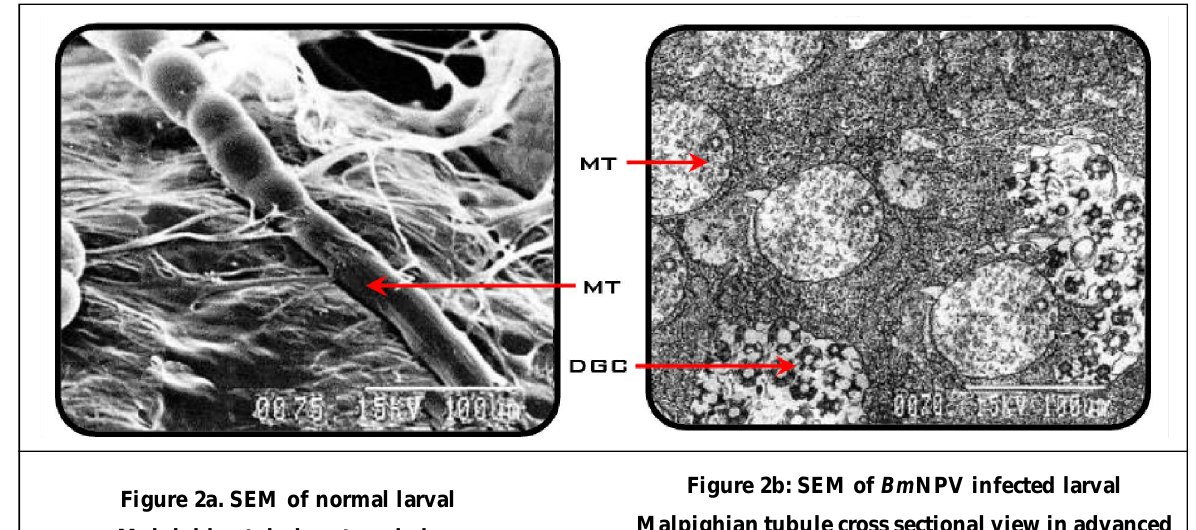
Figure 2a. SEM of normal larval Malpighian tubule external view (×300, MT: Malpighian Tubule)